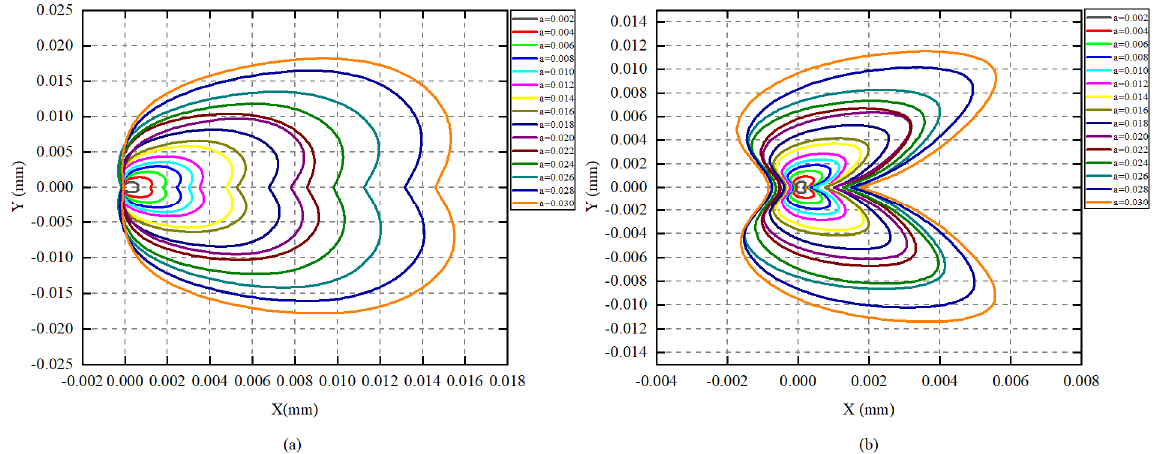
Figure 8. ( a ) Plastic zone of the crack tip with the crack length under plane stress. ( b ) Plastic zone of the crack tip with the crack length under plane strain.